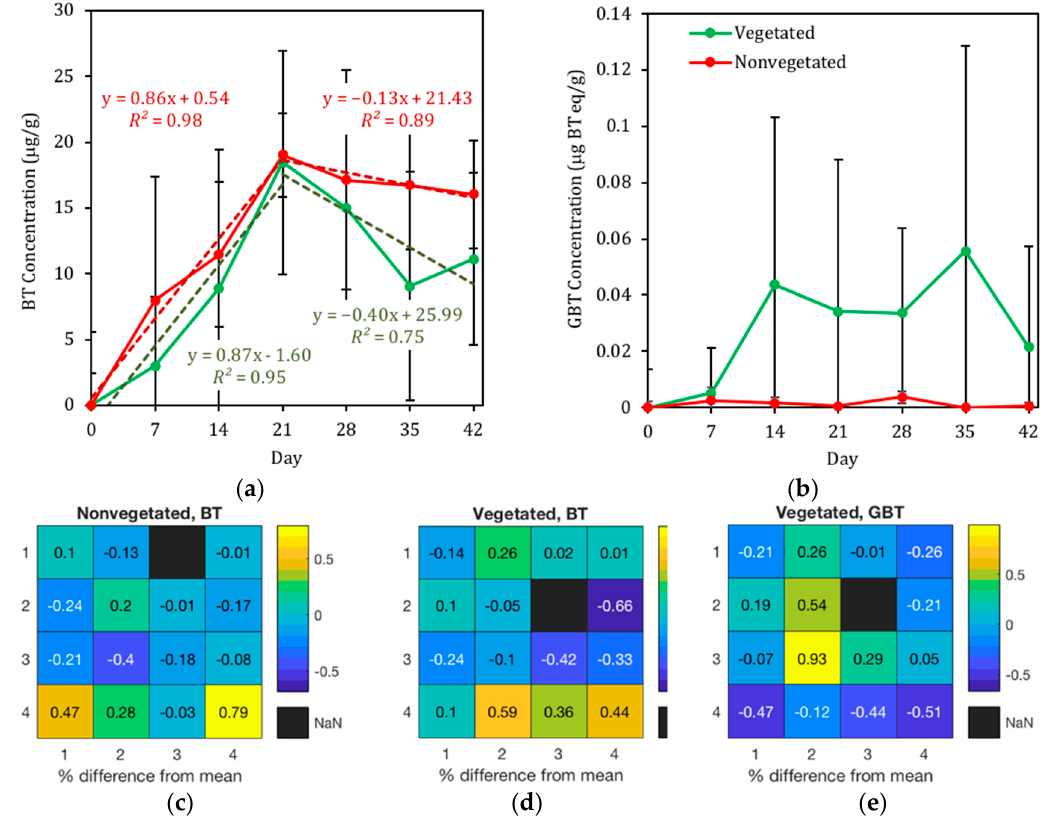
Figure 4. Mean concentration of BT ( a ) and concentration of GBT ( b ) in biofilter mesocosm geomedia (<425 µ m fraction) over the course of the study period in the vegetated biofilters (green) and nonvegetated biofilters (red). Storm events occurred on days 0, 7, and 14. Error bars represent one standard deviation ( n = 9). Linear regressions (dashed lines) are plotted with equation of line of best fit and r-squared values for soil BT concentrations in the vegetated (green) and nonvegetated (red) mesocosms during the storm events ( t = 0–21 days) and extended monitoring period ( t = 21–42 days). Spatial distribution of BT concentrations in the vegetated ( c ) and nonvegetated ( d ) biofilter mesocosms and GBT in the vegetated biofilter mesocosms ( e ). Values reflect the percent difference in concentration of each sample from the mean concentration ( n = 9) for the respective sampling period based on the sample’s location in the mesocosm. Nine locations were sampled once during each time point. No significant GBT concentrations were observed in the nonvegetated mesocosms, so data are not shown. A fully screened monitoring well was located in position (4,4).